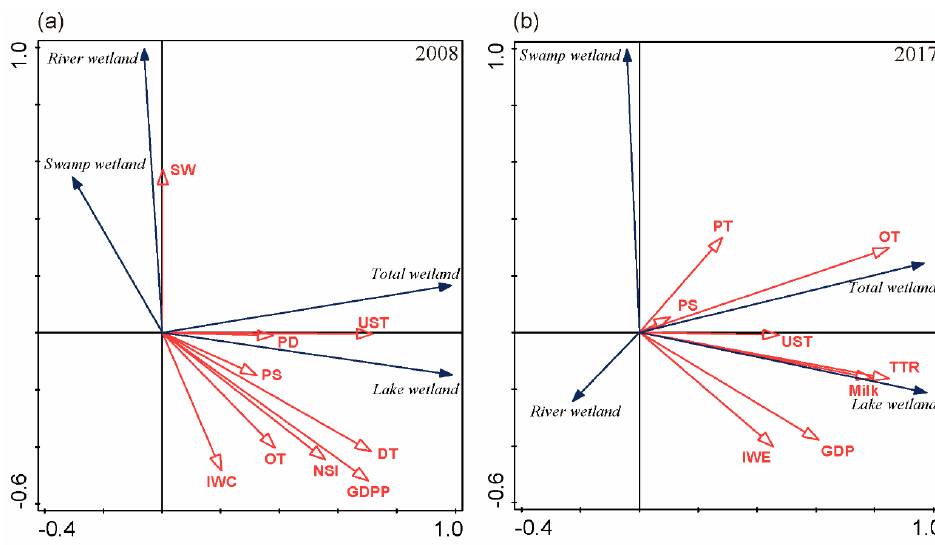
Figure 5. RDA two − dimensional ordination diagram of the plots in 2008 and 2017. The relationship between socio-economic factors and wetland area changes in ( a ) 2008 and ( b ) 2017. DT, domestic tourists; NSI, natural science research institutions; IWC, industrial water consumption; UST, urban sewage treatment; SW, sheep wool; GDPP, GDP per person; PS, percentage of secondary industry; OT, overseas tourists; TTR, total tourism revenue; IWE, industrial waste water emission; GDP, gross domestic product; PT, percentage of tertiary industry; UST, urban sewage treatment; PS, percentage of secondary industry.